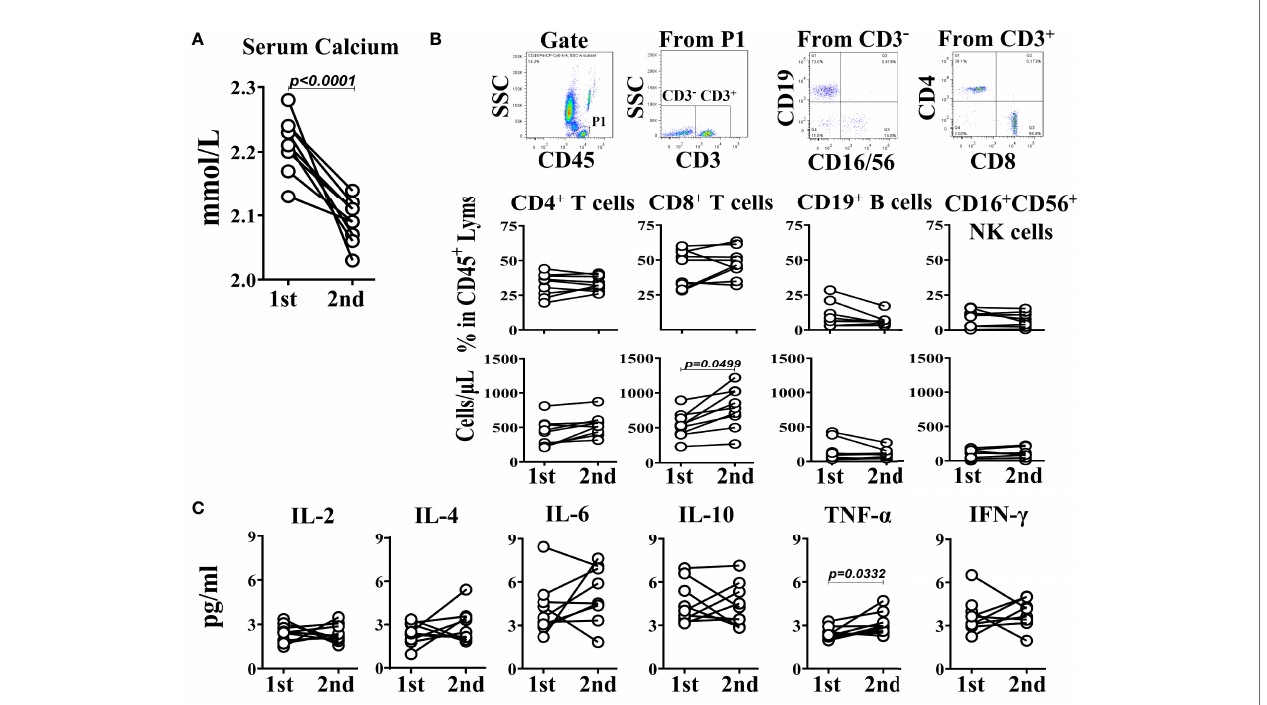
FIGURE 3 | Self-comparison between two measurements in 9 SLE patients. (A) The serum calcium levels. (B) TBNK subsets. (C) The corresponding Th1/Th2 cytokines. The interval between two measurements is within half a